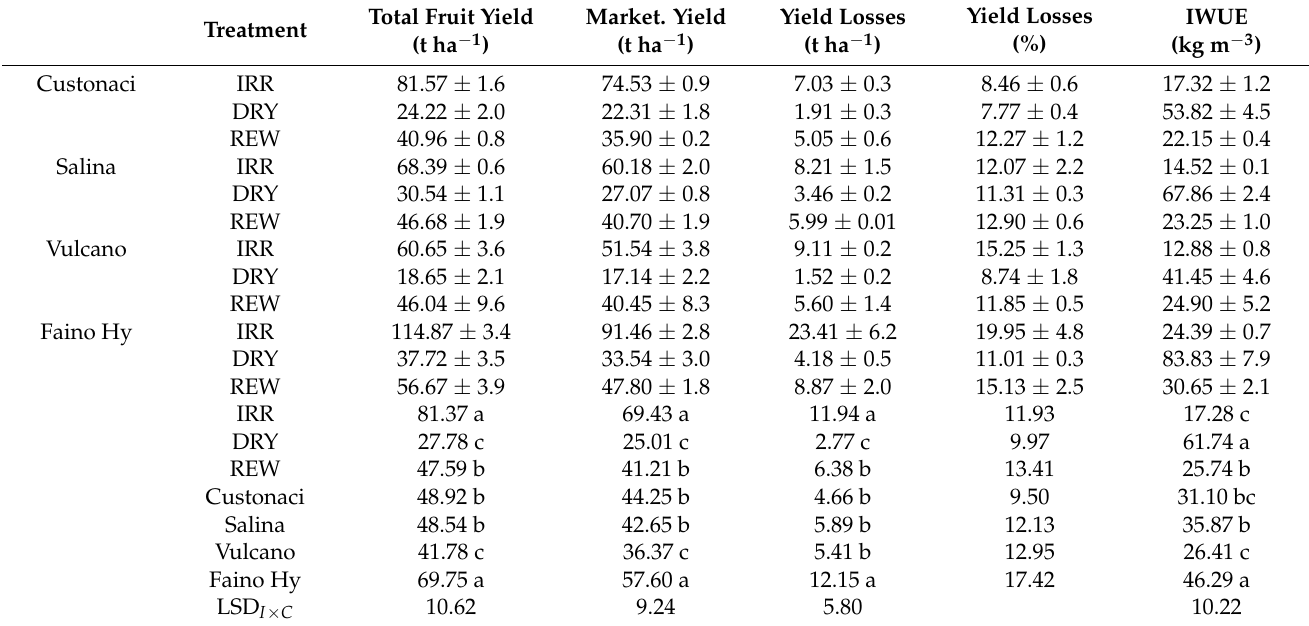
Table 2. Fruit yield (as total and marketable), yield losses, and IWUE in four cultivars of tomato in relation to the irrigation treatments (IRR: full irrigation; DRY: no irrigation; REW: rewatering). Values are mean ± standard error ( n = 3). Values for the main factors followed by the same letter do not statistically differ at p ≤ 0.05 (Tukey’s test). LSD I × C = Least significant difference for the interaction ‘Irrigation ( I ) × Cultivar ( C